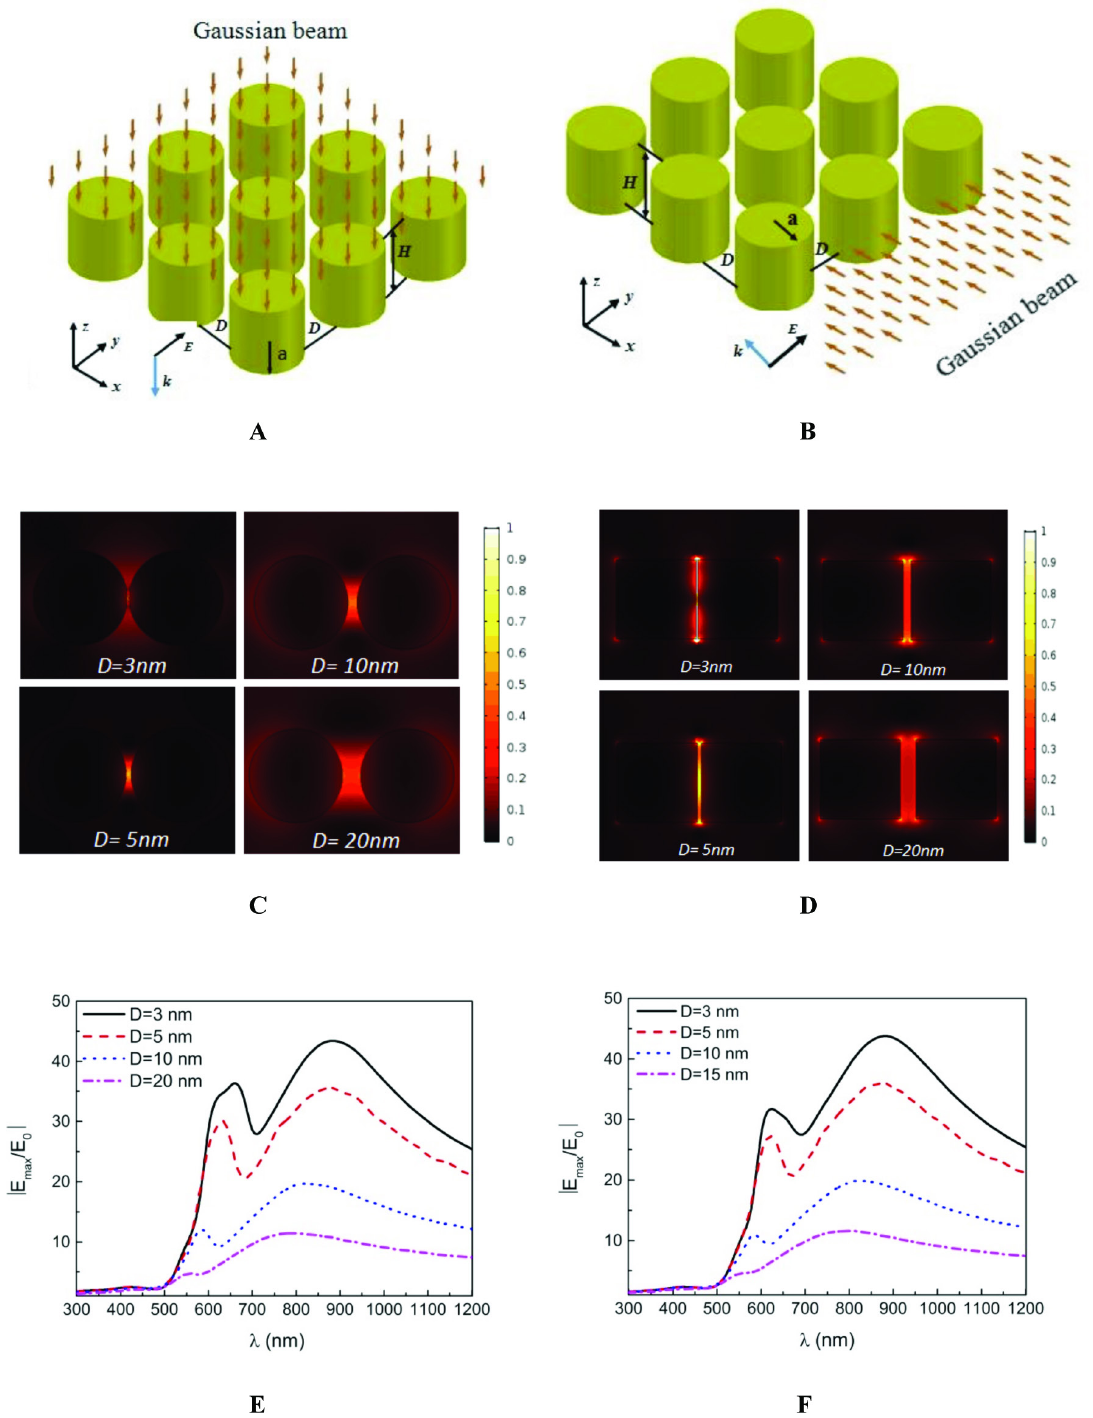
Figure 2: ( A ) Schematic diagram for the Gaussian beam incident on Au nanorod arrays from the longitudinal direction; ( B ) Schematic di- agram for the Gaussian beam incident on Au nanorod arrays from the side direction; ( C ) Electric field distribution ( | E | ) around the Au nanorod dimer on the x-y section with the Gaussian beam longitudinal incident ( λ 0 = 633 nm); ( D ) Electric field distribution ( | E | ) around Au nanorod dimer on y-z section with the Gaussian beam side incident ( λ 0 = 633 nm); ( E ) The curve of | E max / E 0 | with the working wave- length for longitudinal incidence; ( F ) The curve of | E max / E 0 | with the working wavelength for side incidence; ( | E max | is the maximum electric field on the plane formed by the long axis of two nanorods, | E 0 | =1V/m is the amplitude of the incident Gaussian